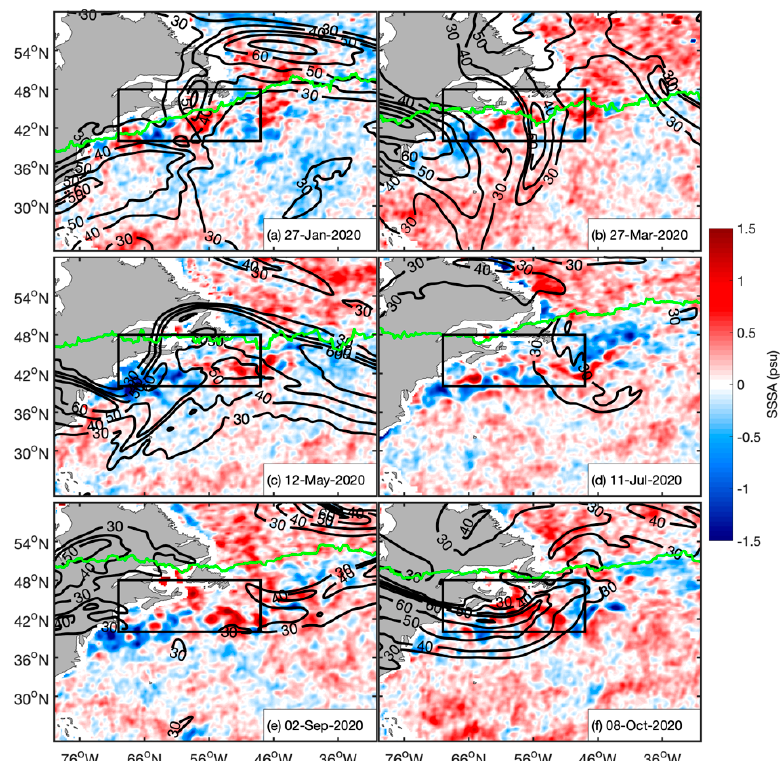
Figure 8. Spatial map of SSSA (psu) in the NW Atlantic throughout 2020. Black contour lines indicate wind speeds (m/s) at 300 hPa and the location of the Jet Stream. Green lines show the mean Jet Stream position based on the daily wind speed at 300 hPa from 1981–2020. Time series data was averaged over 40–48°N and 70–48°W indicated by the box.